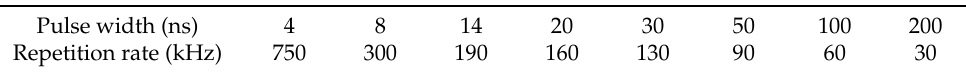
Table 4. Parameter settings for various pulse widths at an average power of 30 W and scan rate of 5